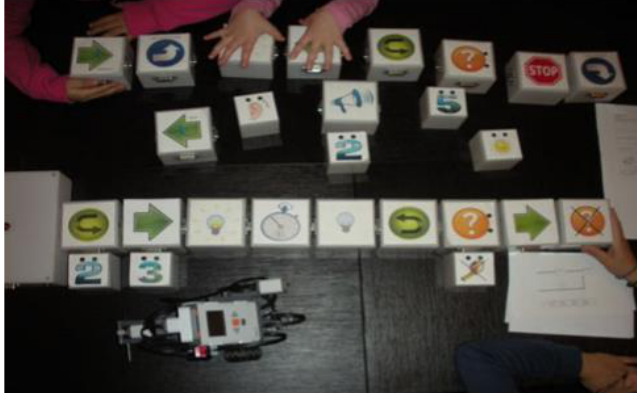
Figure 22. Tangible programming blocks for programming LEGO NXT robot [40].